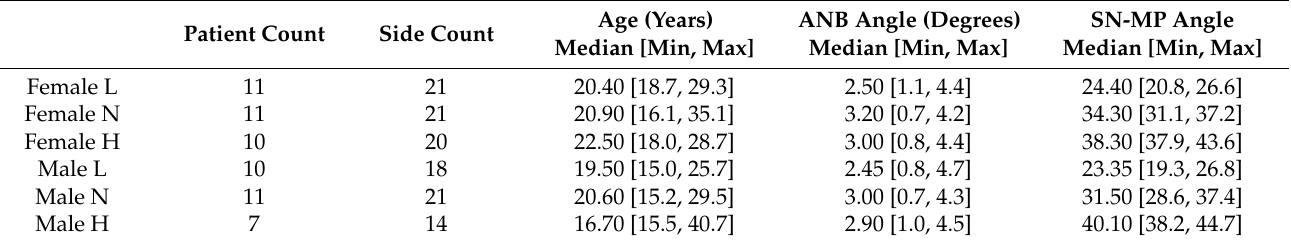
Table 1. The demographic information of the subjects included in the current study. L: low angle; N: normal angle; H: high